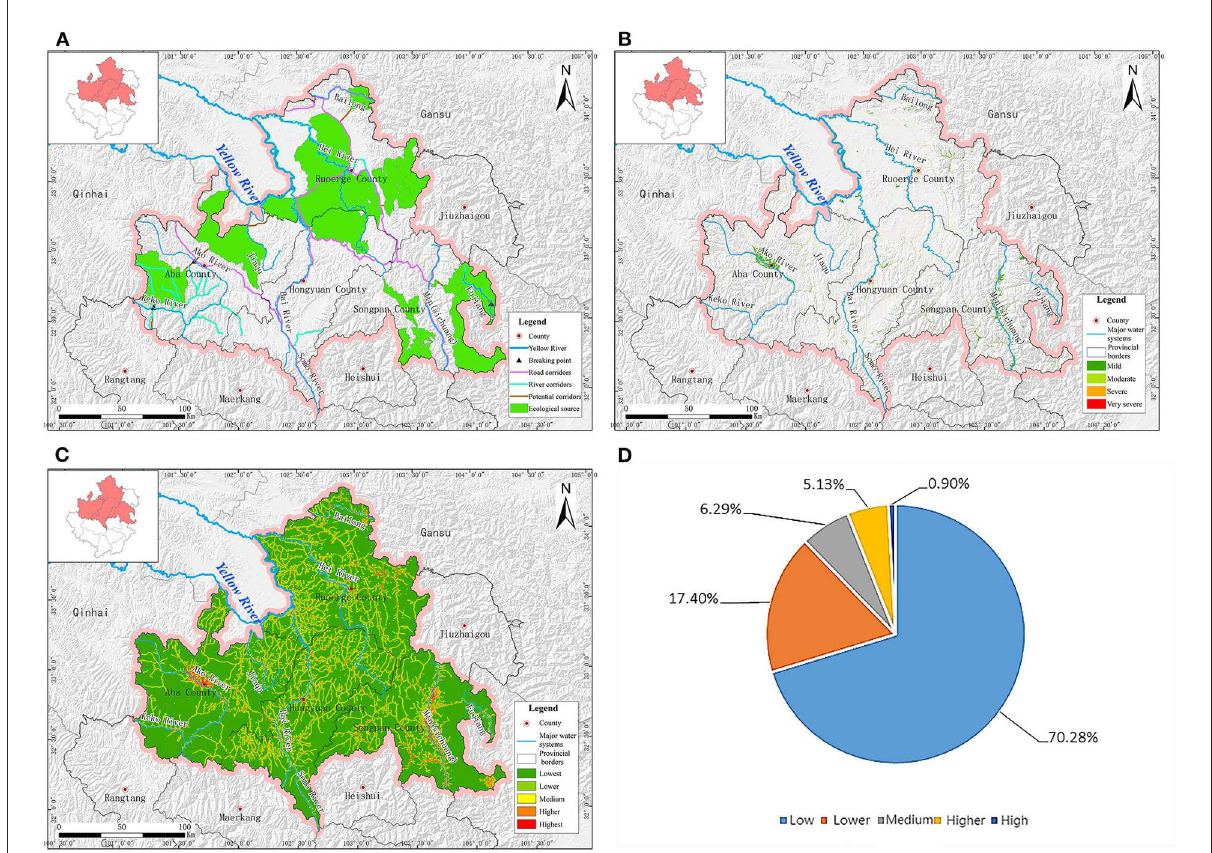
FIGURE15 Ecological and environmental problems. (A) Ecological corridors. (B) Landscape fragmentation. (C) Human activity interference degree diagram. (D) Statistic of human activity interference degree.